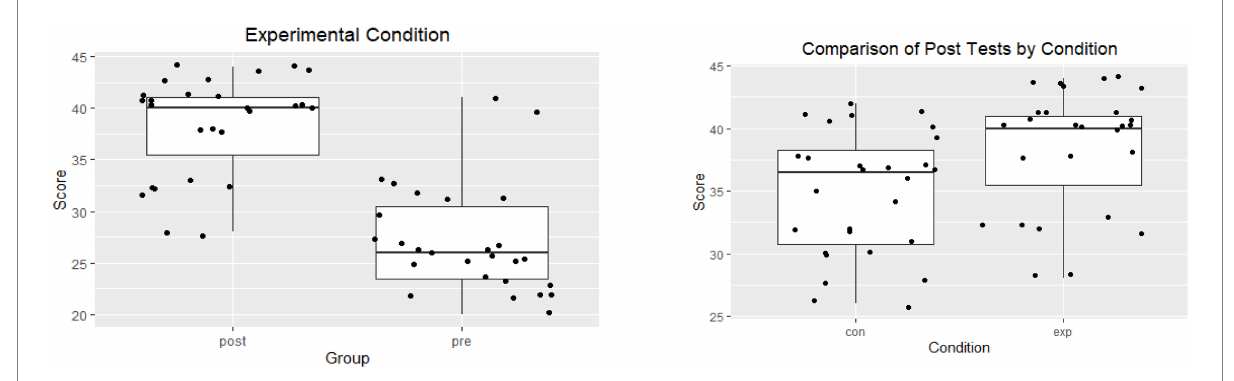
FIGURE 3 Comparison of control and experimental groups pre- and post-test scores.